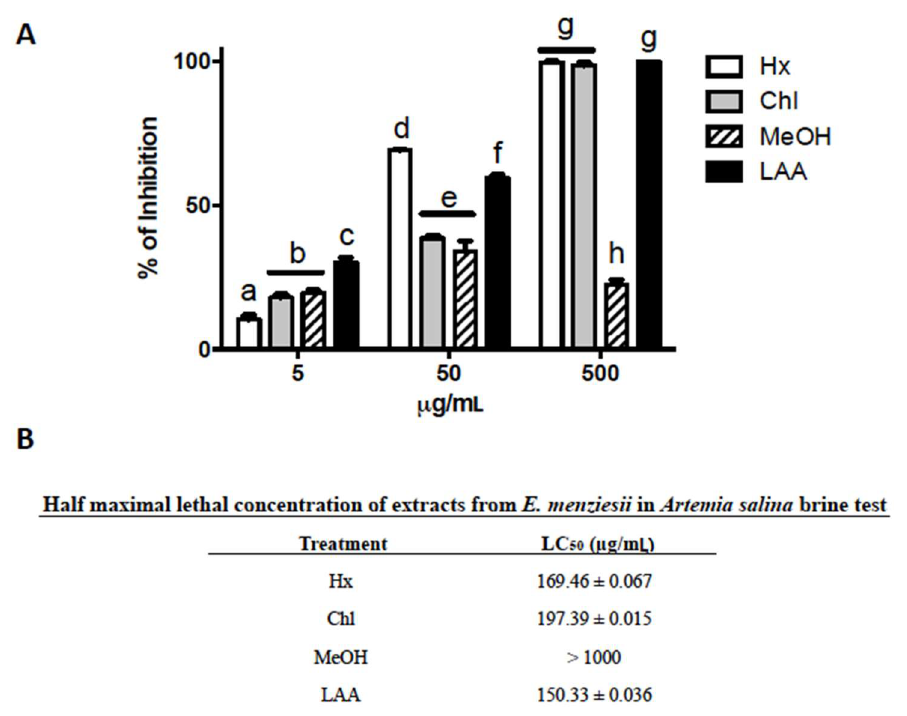
Figure 1. Cytotoxic activity of E. menziesii ’s extracts over Artemia salina brine shrimp. ( A ) Percentage of brine shrimp death at 5, 50 or 500 μg/mL of hexane (Hx), chloroform (Chl) or methanol (MeOH) extracts obtained from E. menziesii seaweed for 24 h. L -Ascorbic acid (LAA) and artificial seawater were used as positive and negative controls, respectively. Data are expressed as the mean ± SEM of at least three independent experiments. Statistical differences were determined by two-way ANOVA, and differences among groups by Tukey’s test with multiple comparisons. a–g nomenclature: the same lowercase letters on each bar mean there are not differences among treatment values; conversely, distinct letters indicate significant differences within treatments ( p < 0.01). ( B ) Half maximal lethal concentration (LC 50 ) of Hx, Chl and MeOH extracts, and LAA was determined by linear regression.